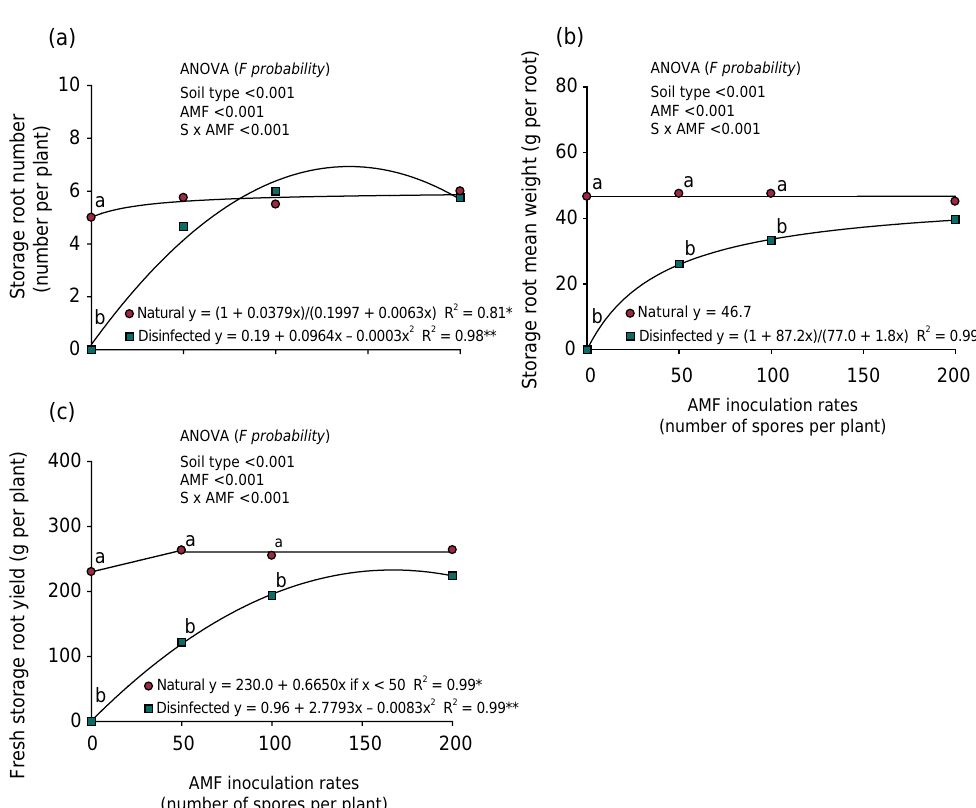
Figure 2. Number of storage roots per plant (a), storage root mean weight (b) and fresh storage root yield (c) of the cassava in response to AMF inoculation rates in natural and disinfected soils. Within each AMF inoculation rate, different lowercase letters indicate a significant difference between soil types, whereas the absence of lowercase letters indicates a non-significant difference between soil types at p≤0.05. * p≤0.05; **